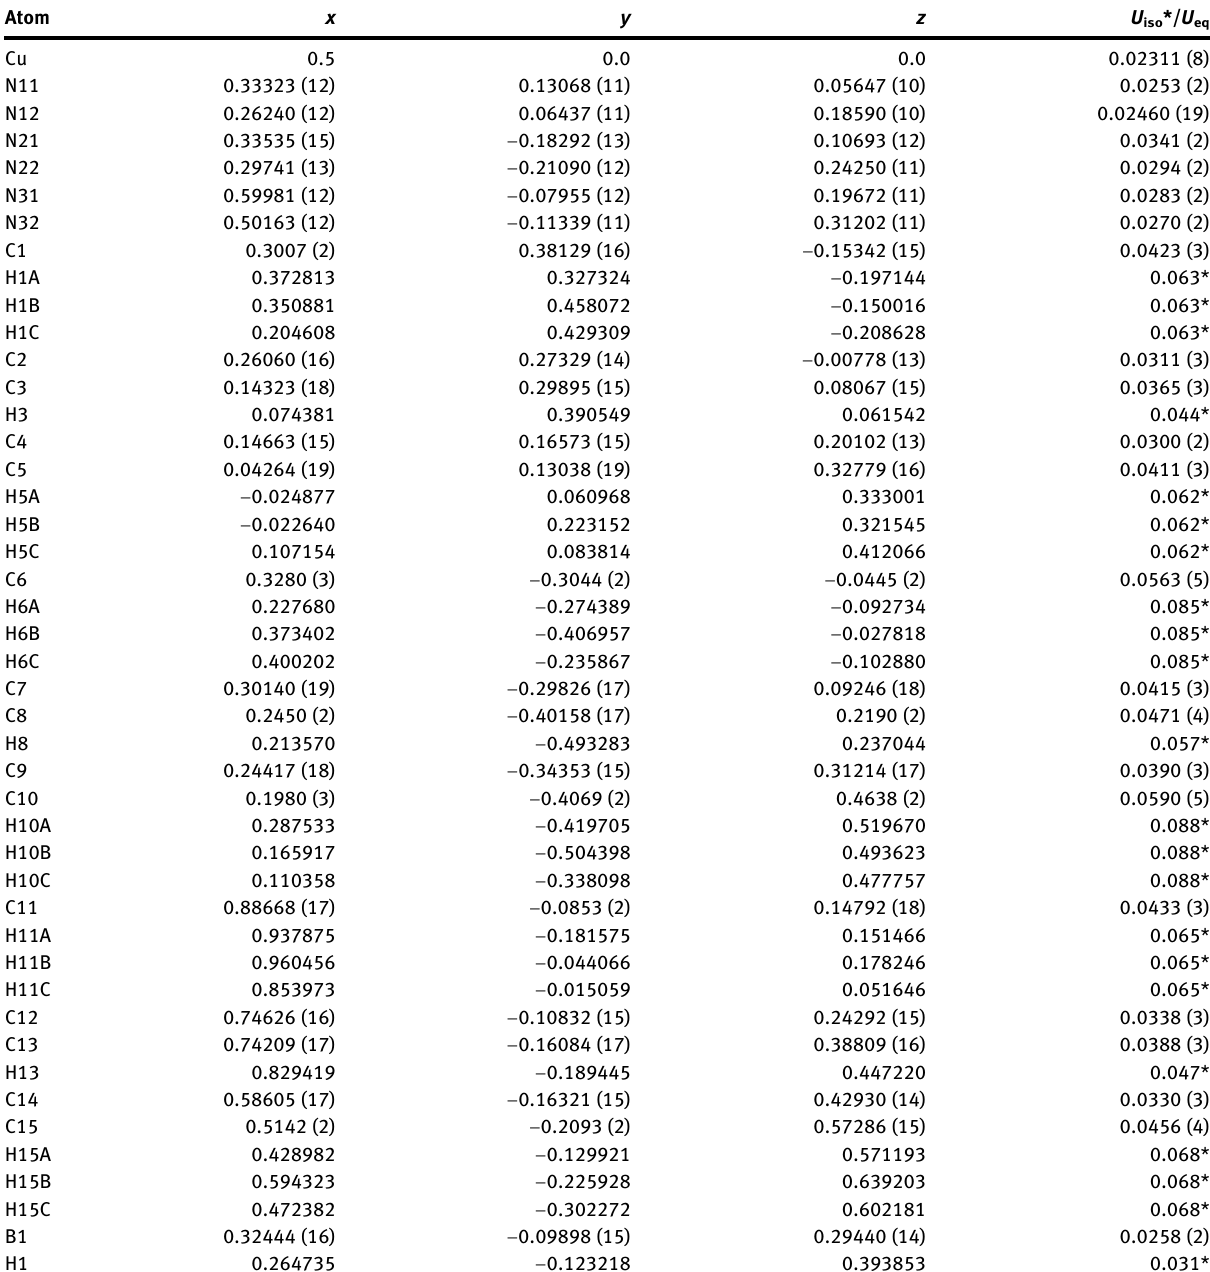
Table  : Fractional atomic coordinates and isotropic or equivalent isotropic displacement parameters (Å  ).